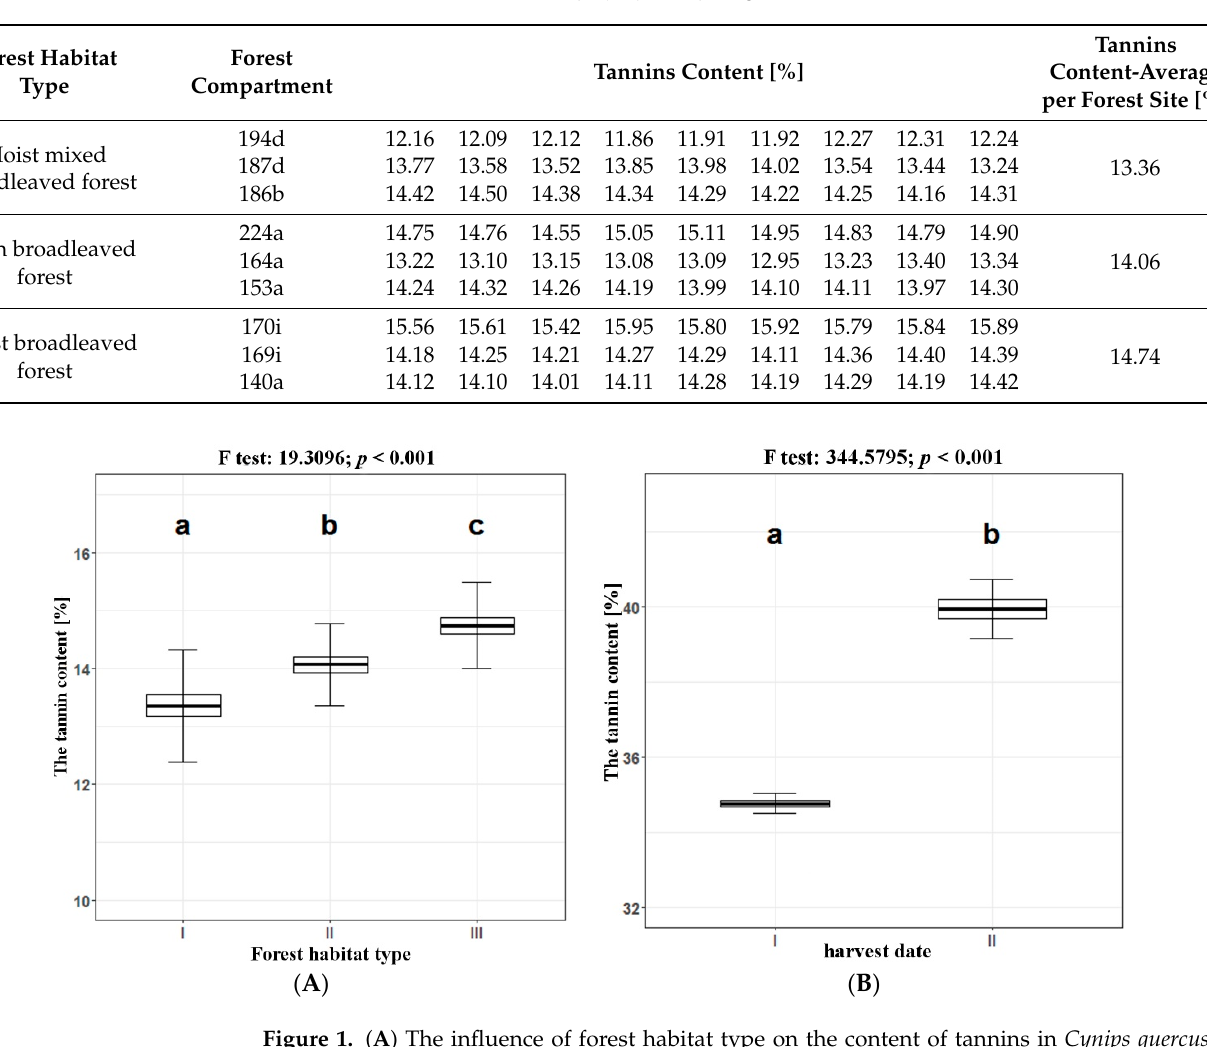
Table 2. Content of tannins in Cynips quercusfolii gall nuts.